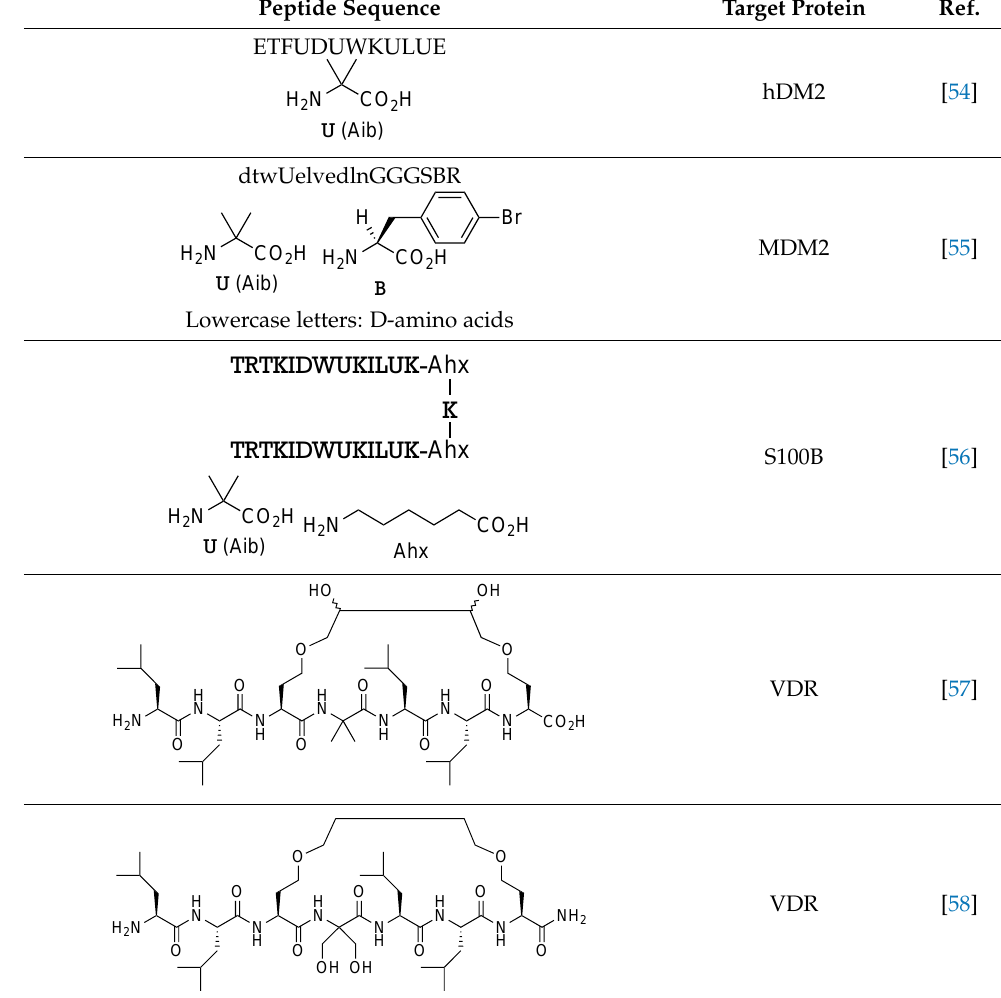
Target Target Ref. Protein